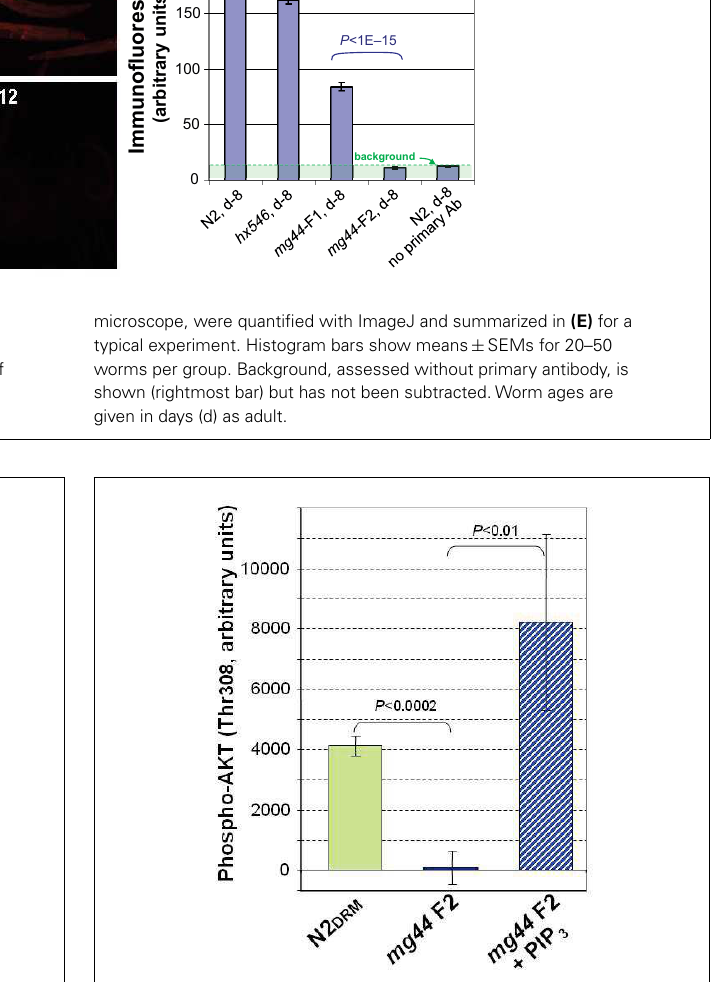
FIGURE 4 | Functional assay of PIP 3 based on phosphorylation of AKT(Thr 308 ). Bacterially synthesized AKT, with an N-terminal His 6 tag, was added to cleared C. elegans lysates, and after 1h at 20˚C, was bound to AKT monoclonal antibody on AlphaBeads (PerkinElmer) in an AlphaScreen PI3K Assay (Echelon), and scored for also binding a tagged antibody to AKT(P-Thr 308 ). Results were read on an Envision 2104 Microplate Reader (PerkinElmer). Error bars are standard deviations ( N =